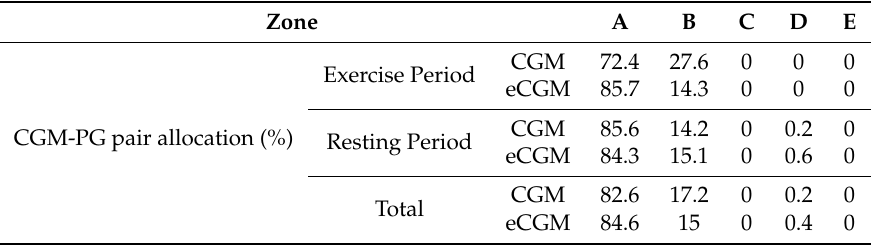
Table 5. Table of the results for the classification of the CGM samples in the different Clarke EGA zones. CGM-PG refers to paired CGM and PG